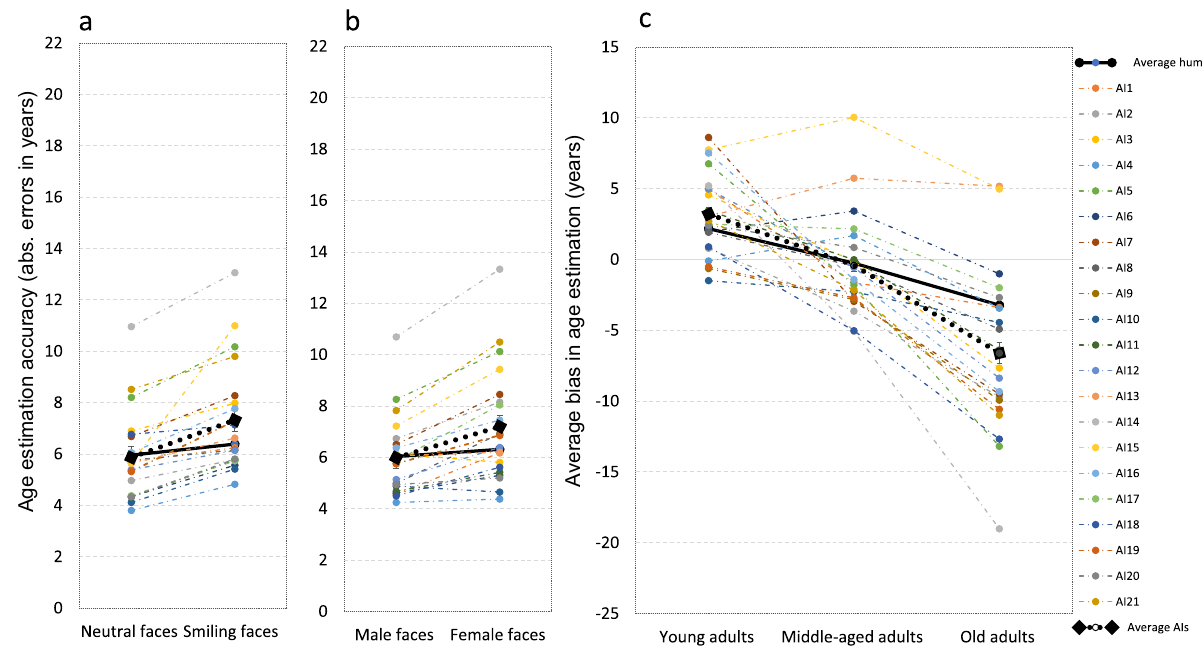
Figure 3. ( a ) Average age estimation accuracy for neutral and smiling faces across age group and gender. As in human performance, AI accuracy decreased for smiling compared to neutral faces. This decrease was larger for AI compared to humans ( b ) Average age estimation accuracy for male and female faces across age group and expression. As for humans, AI age estimation accuracy decreased for female compared to male faces. This decrease was larger in AI. ( c ) Age estimation bias for the different AIs across expression and gender. As in human age estimations, AI showed overestimation of age for faces of younger adults and underestimation of age for faces of older adults. Again, this effect was more pronounced in AI compared to